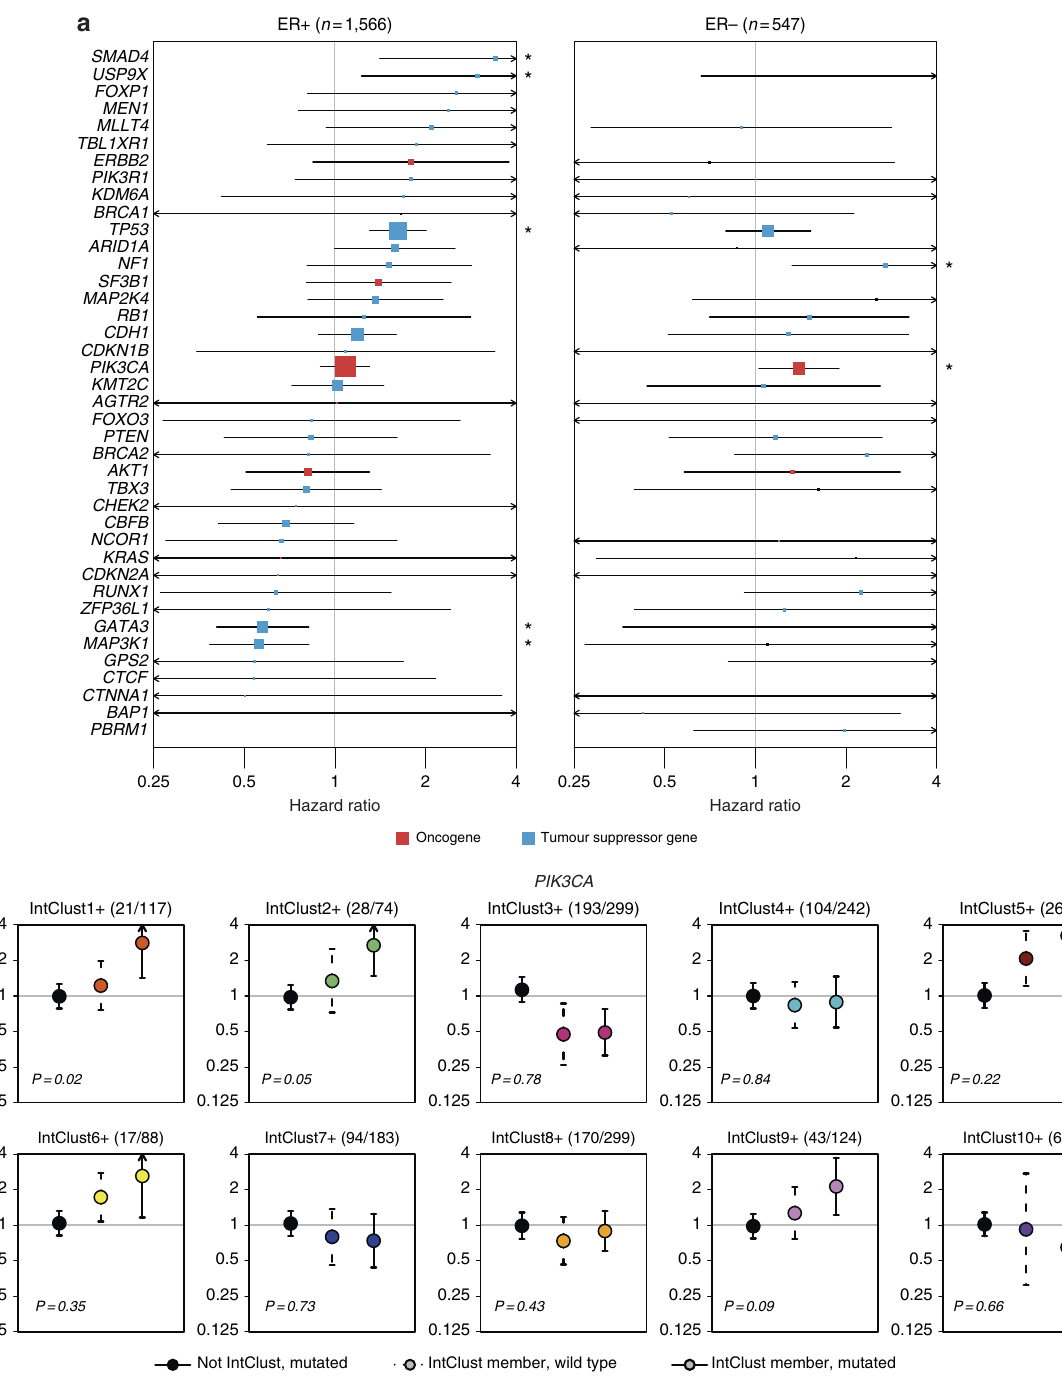
Figure 6 | Associations between mutations in the 40 Mut-driver genes and survival. ( a ) Multivariable Cox proportional hazards models were constructed to assess the associations between functional mutations in Mut-driver genes and breast cancer-specific survival (BCSS) in ER þ (left) and ER (cid:3) (right) cancers. For oncogenes (red), we considered only recurrent mutations, whereas only inactivating mutations were used for tumour suppressor genes (blue). Both classes of mutations were used for TP53 . The lines represent 95% confidence intervals and sizes of the boxes correspond to the inverse of the interval size. Arrows indicate confidence intervals extending beyond plot range, and ‘ (cid:4) ’ mark genes where mutations are associated BCSS at P o 0.05. Some genes did not have sufficient mutations in the ER (cid:3) cohort to obtain a hazard ratio estimate. ( b ) The association between functional PIK3CA mutations and BCSS were analyzed in ER þ tumours after stratifying by IntClust. For each IntClust, univariable Cox models were constructed to obtain a hazard ratio estimate for PIK3CA mutations in tumours not belonging to the particular IntClust (left; black point, solid line), the effect of IntClust membership for tumours with wild-type PIK3CA (middle; coloured point, dashed line), and the simultaneous effects of PIK3CA mutation and IntClust membership (right; coloured point, solid line). Lines and arrows represent confidence intervals as in Fig. 6a. The P values represent the significance of the interaction between PIK3CA mutation and IntClust membership in the Cox model. The fraction of tumours harbouring PIK3CA mutations within each IntClust is also indicated in